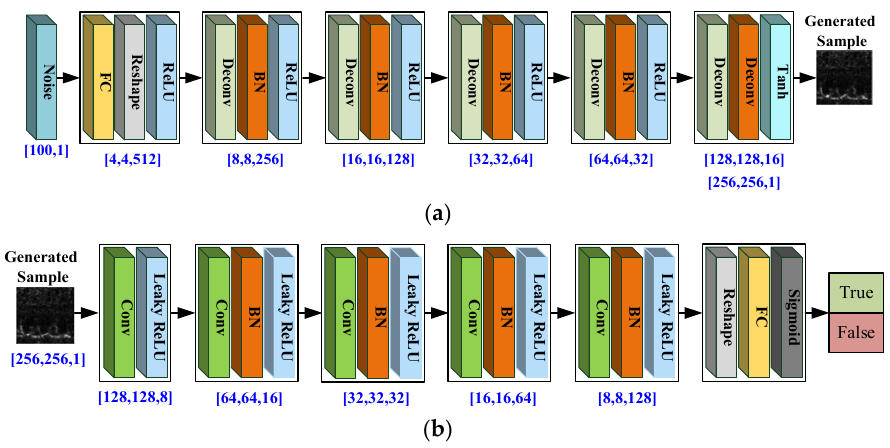
Figure 2. The DCGAN architecture. ( a ) Generator; ( b ) discriminator.